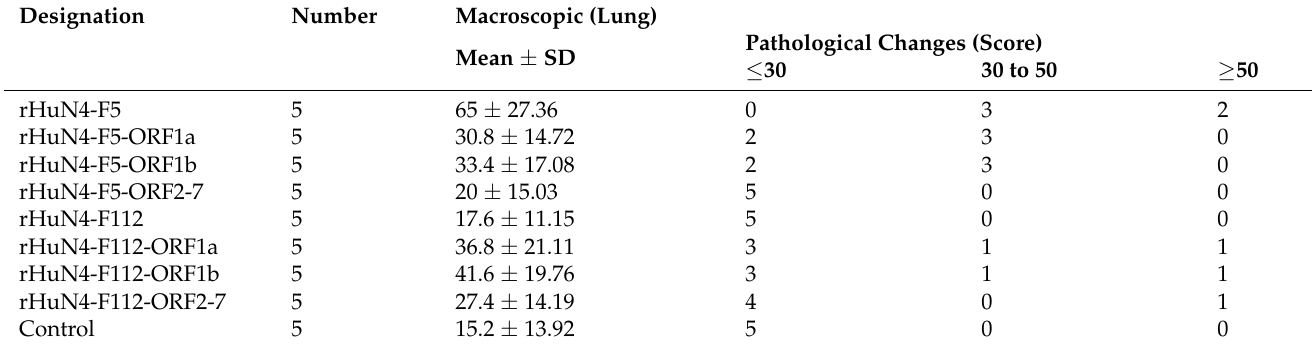
Table 1. Mean values ( ± SD) of macroscopic scores of lung tissues after